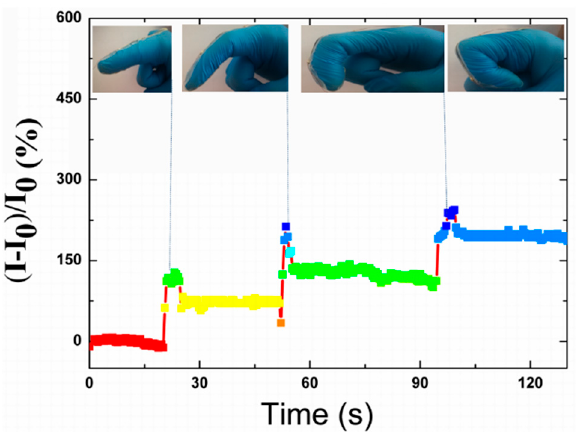
Figure 10. Relative current responses of a strain sensor in detecting various degrees of the forefinger’s bending. Inserts are the images of various bending degrees.